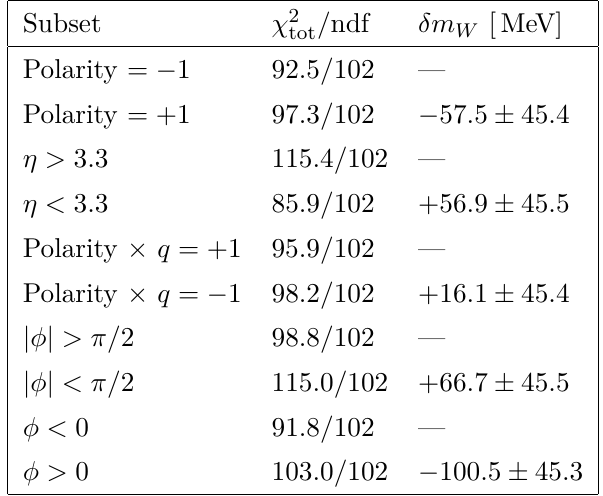
Table 7 . Fit results where the data and simulation samples are split into two orthogonal subsets. For a given split, the first row is defined as the reference with respect to which the difference in m W , denoted by δm W , is defined. The uncertainties quoted on δm W are statistical.